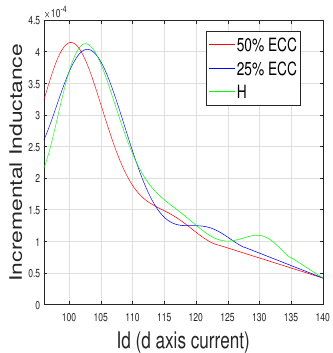
Figure 15. Experimental results for Incremental Inductance curves vs. I d at different severities.